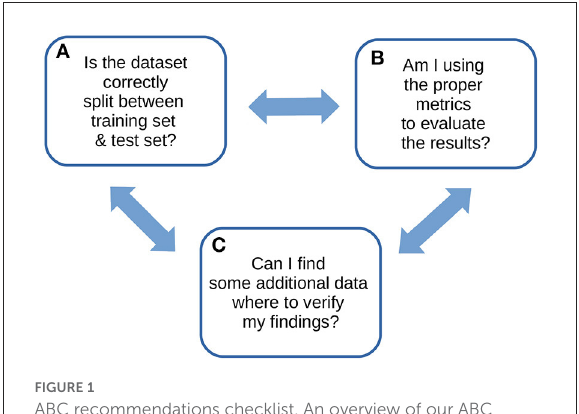
FIGURE1 ABC recommendations checklist. An overview of our ABC recommendations, to keep in mind for any machine learning